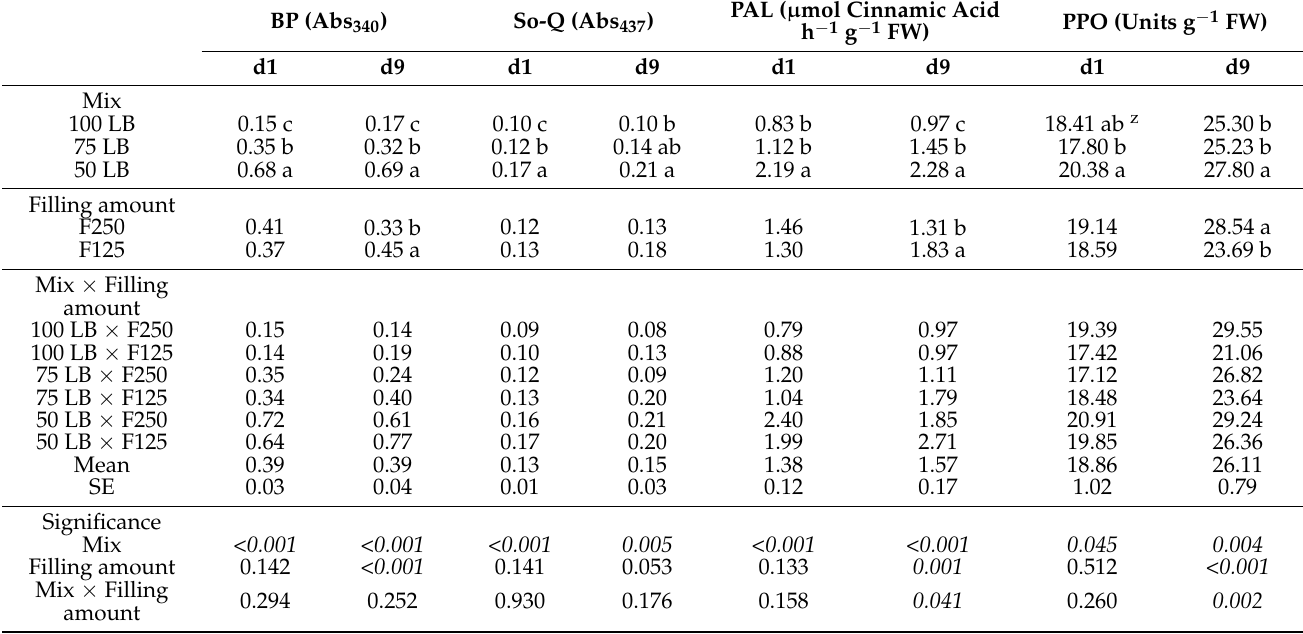
Table 4. Tissue browning parameters of the fresh-cut baby leaf lettuce and rocket during